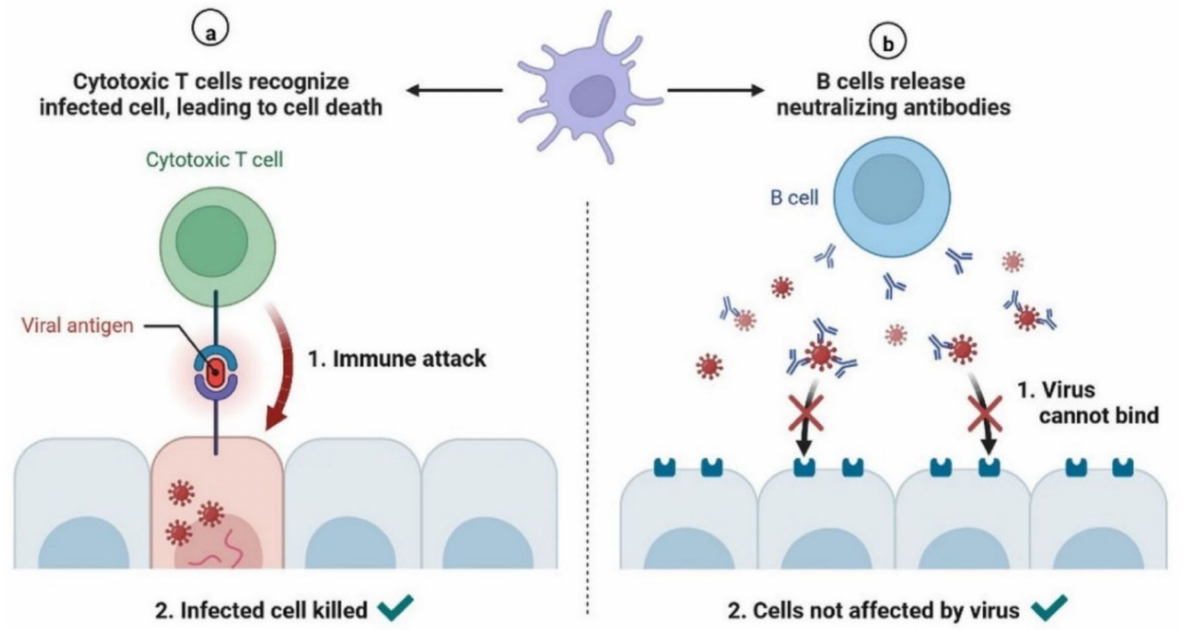
Figure 9. Immune Mechanisms Affected by COVID-19: ( a ) Cytotoxic T cells recognise infected cells, leading to cell death. ( b ) B cells release neutralising antibodies, which prevent the binding of the